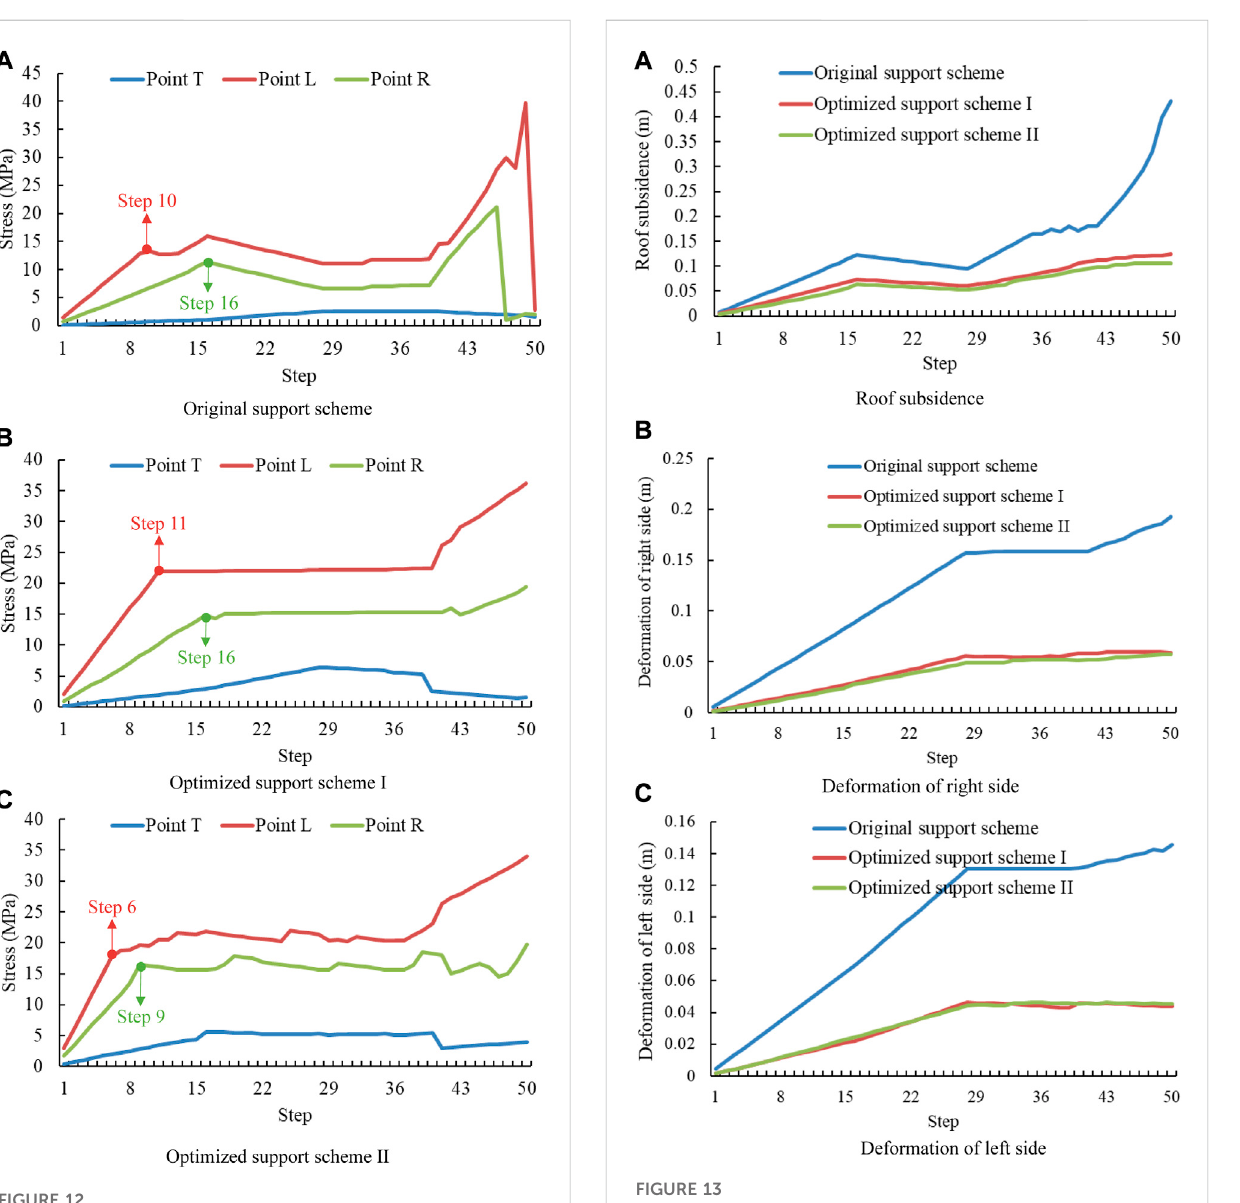
FIGURE 12 Variation trend of surrounding rock stress under various support